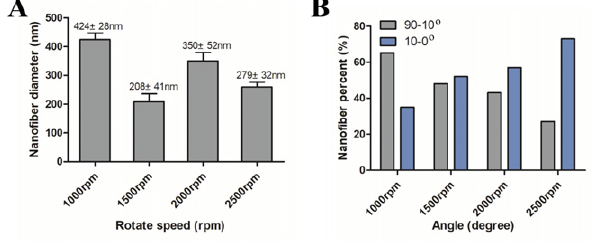
Figure 5: Fiber diameters and angular percentage of PAN nanofiber membranes (12wt%) at different rotary speeds: A) Diameters; B) Percentage of angle 10-0 ∘ and 90-10 ∘ with 0 ∘ direction.